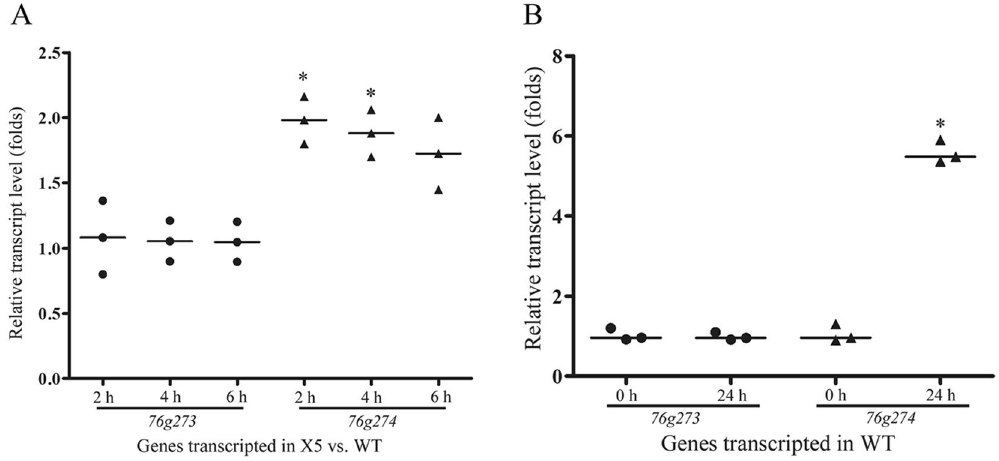
Figure 3. Transcriptional analysis of genes 76g273 and 76g274 in WT and X5. β -tubulin gene (AOL_ s00076g640) of A. oligospora was used as the reference standard. ( A ) The transcription of 76g273 and 76g274 in WT and X5 at 2 d, 4 d and 6 d, respectively. * P < 0.05 versus WT. ( B ) The transcriptional levels of genes 76g273 and 76g274 in WT after induced by nematodes for 0 h and 24 h. * P < 0.05 versus 0 h. The horizontal bars depict the median, and data are presented as suggested by Weissgerber et al . 58 and Klaus 59